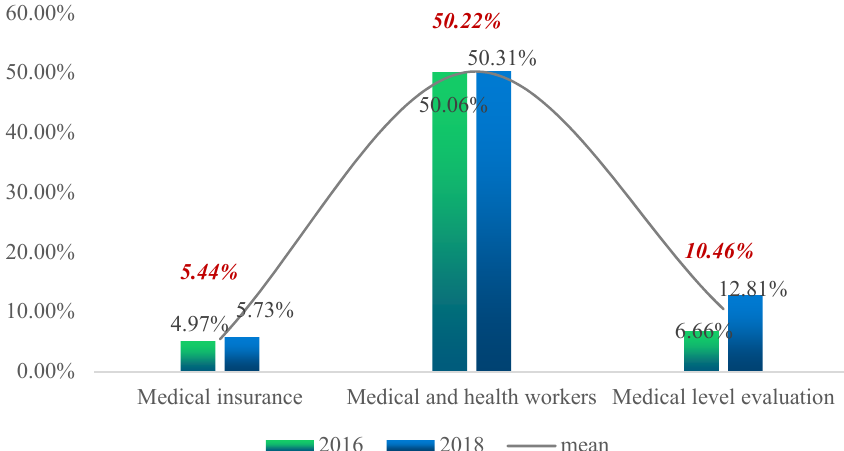
Figure 5. Proportion of the poor for each indicator of the health service and security rights dimen- sion.